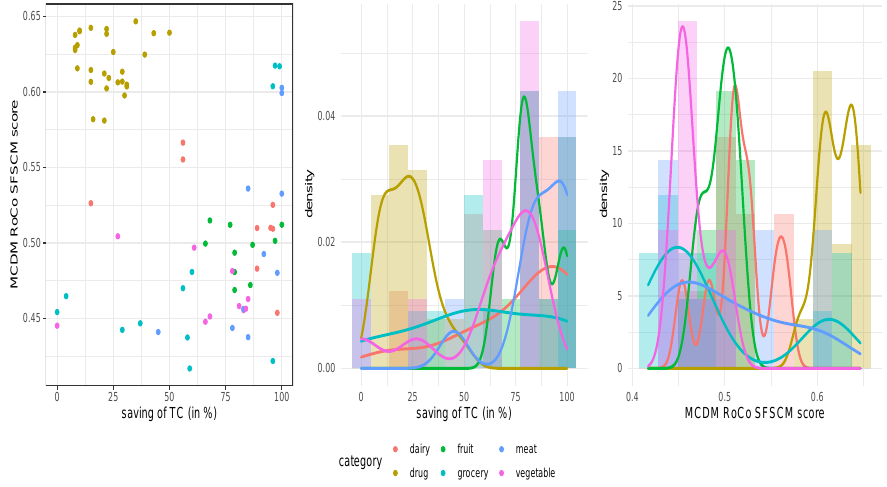
Figure 5. Scatterplot ( first panel ) and density plots ( second and third panels ) for saving of inventory cost (in %) versus MCDM RoCo SFSCM score (expressed as a proportion between zero and one) by